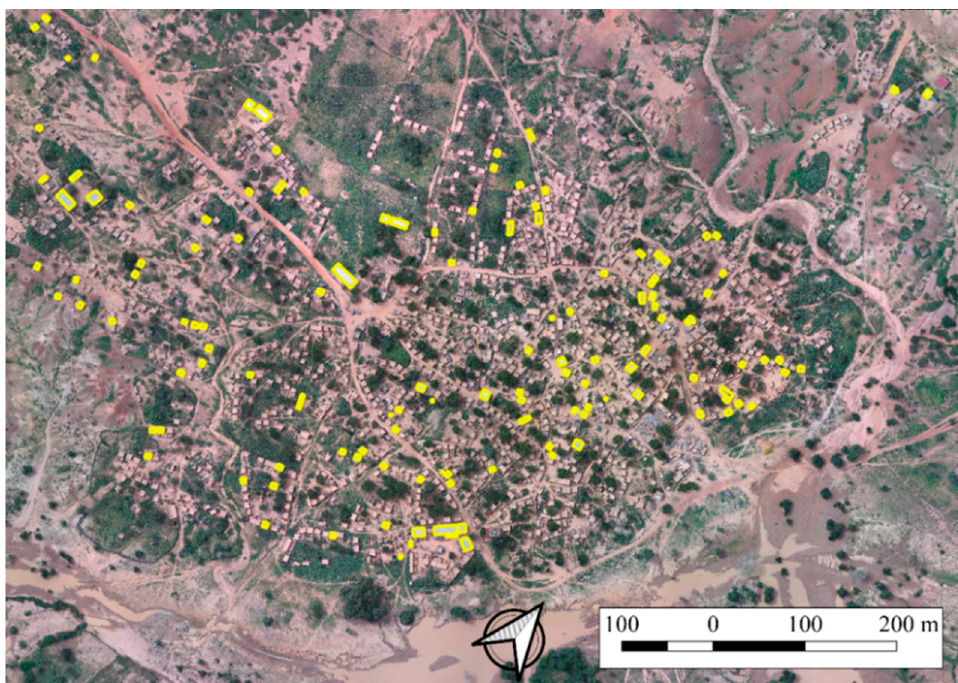
Figure 6. Position of the reference objects within the study area.